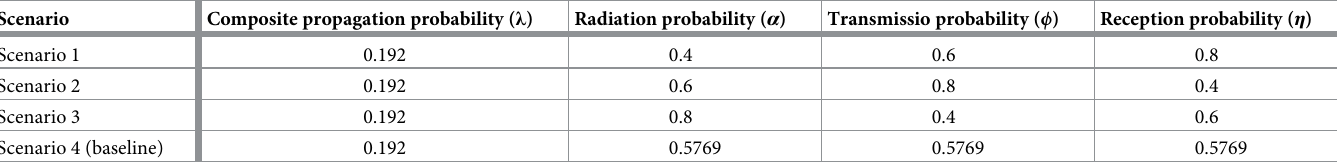
Table 2. Four scenarios with varying decomposition of the sub-processes of